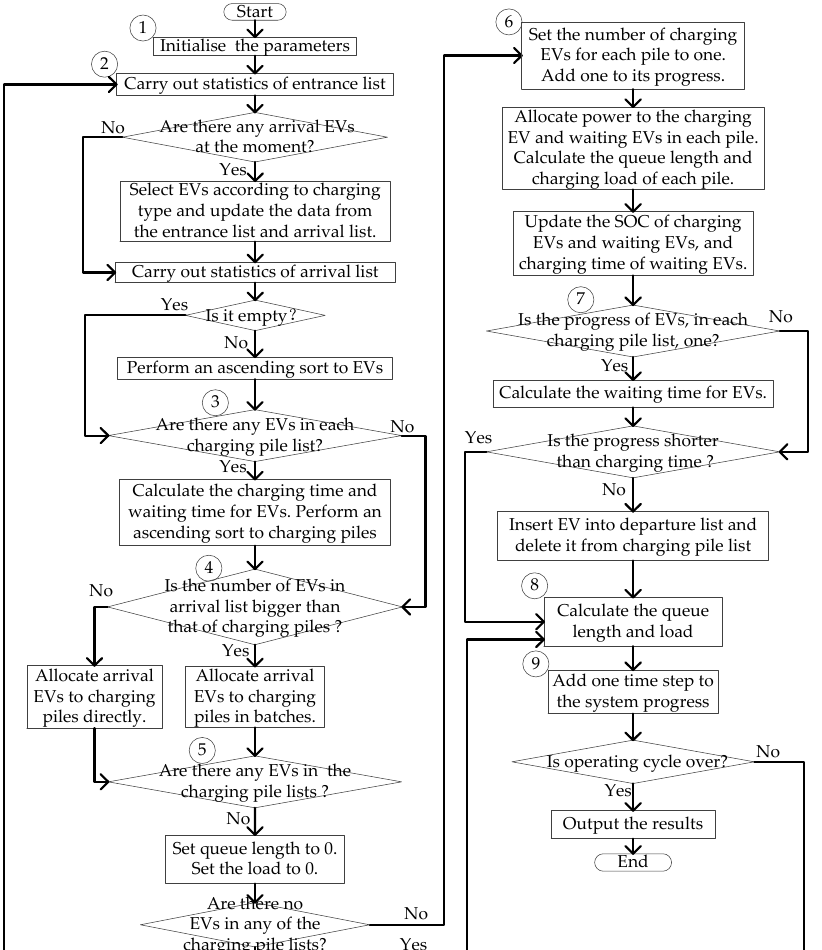
Figure 4. The flowchart of the improved queuing algorithm (IQA).